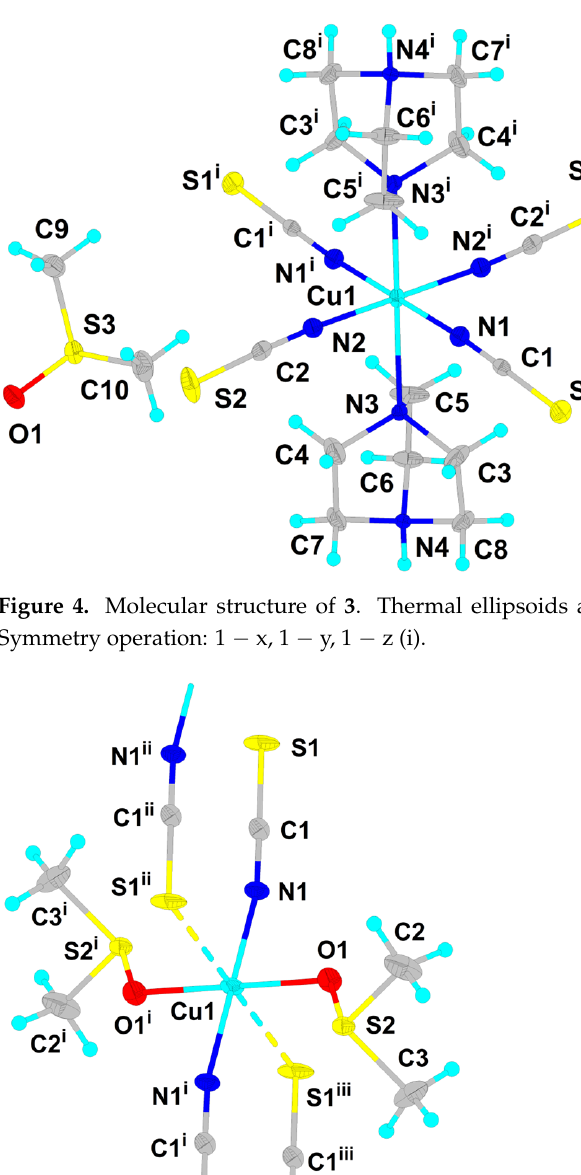
Figure 4. Molecular structure of 3 . Thermal ellipsoids are drawn at the 50% probability level. Sym- metry operation: 1 − x, 1 − y, 1 − z (i).